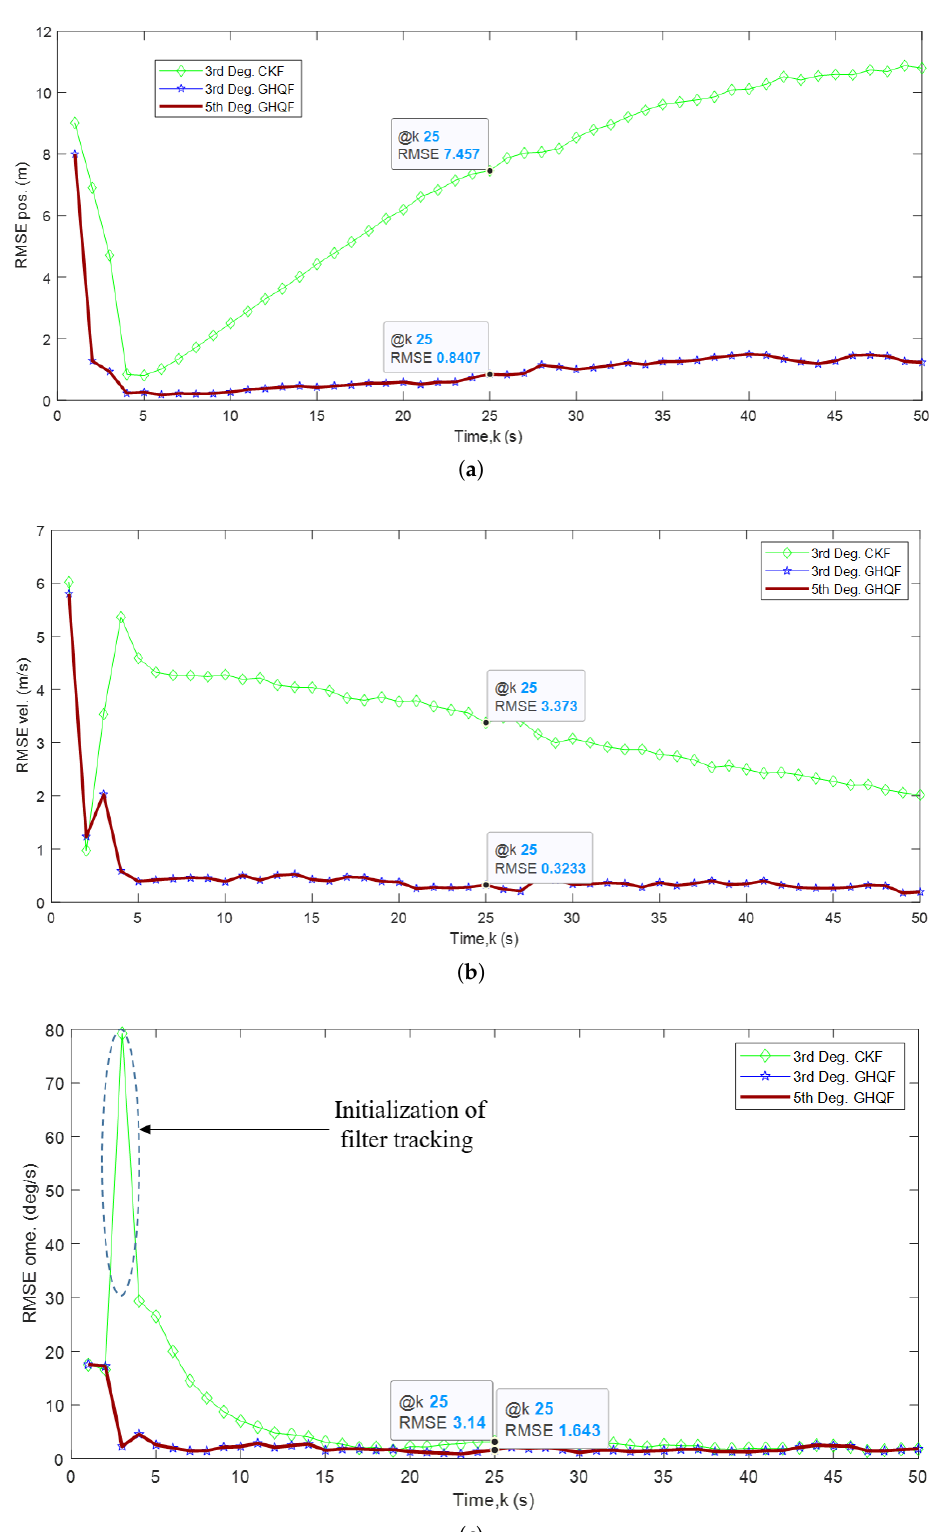
Figure 18. RMSE of GHQF approach based on TDOA/FDOA: In this figure, the lower error bound was achieved by GHQF 3rd and GHQF 5th. It appears the RMSE convergence speed is perfect when using GHQF 5th degree based on hybrid TDOA/FDOA compared to conventional filters. ( a ) RMSE of position. ( b ) RMSE of velocity. ( c ) RMSE of